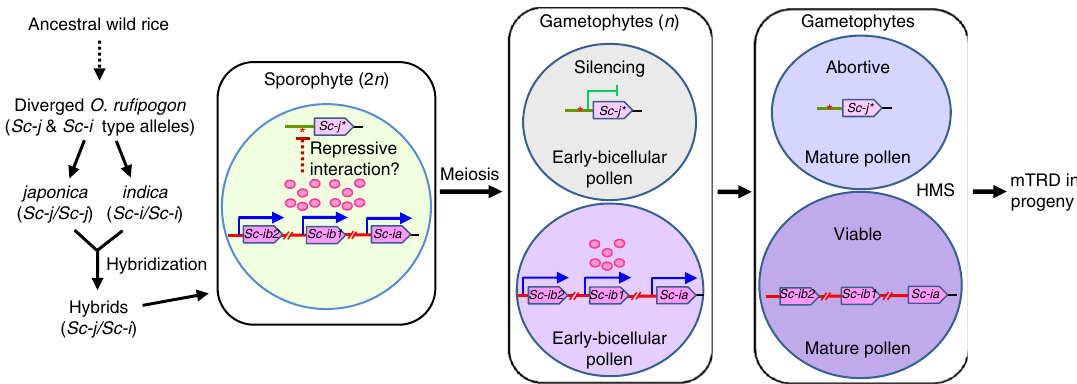
Fig. 5 A proposed model for the molecular genetic mechanism of Sc -mediated HMS. In a japonica – indica hybrid, the Sc-i paralogs are highly expressed in sporophytic cells and the product may interact with the Sc-j promoter region. This might cause transcriptional-repressive epigenetic modi fi cation(s) (red asterisk) in the Sc-j promoter region. This putative modi fi cation state ( Sc-j* ) could be retained, through meiosis, in the male gametophytes, thus causing allelic suppression of Sc-j expression and the consequent Sc-j- speci fi c pollen abortion (HMS) and mTRD. Only two of the four pollen grains from a meiocyte, and one Sc-j copy and one set of Sc-i copies in the bicellular and tricellular pollen grains, are